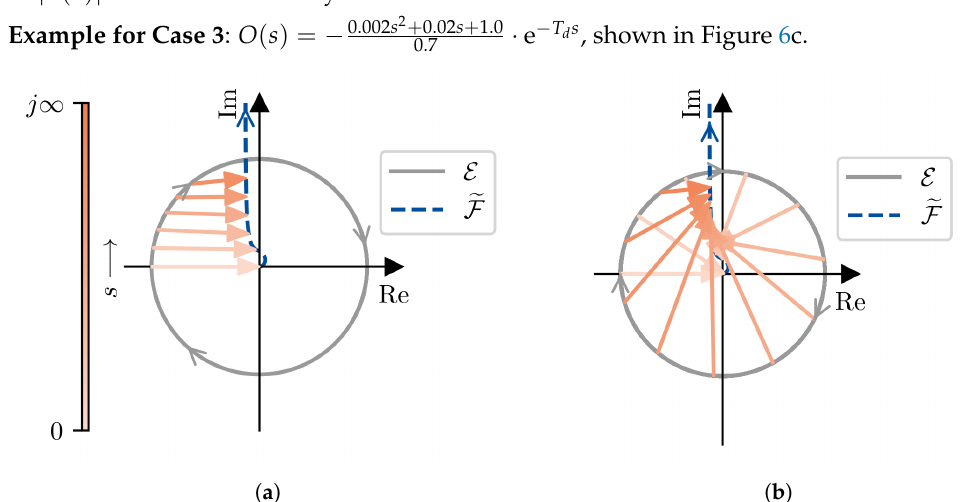
Figure 7. The beginning of the curves (cid:101) F and E drawn for a stable and unstable system that corre- sponds to Case 2. ( a ) stable: no change of the total variation of the argument of the complex vector. ( b ) unstable: the tail of the complex vector rotates around its tip before (cid:101) F exits the unit